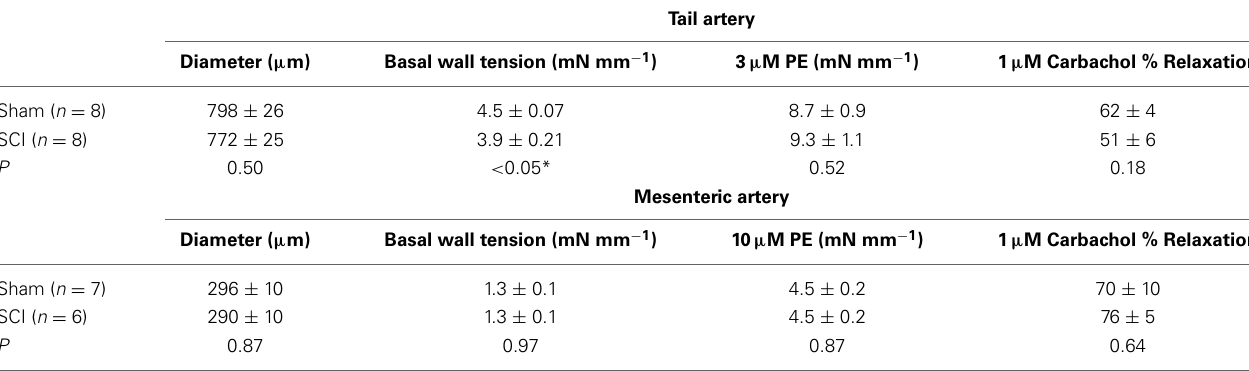
Table 1 | Basal lumen diameter and wall tension and the responses to phenylephrine (PE) and carbachol in tail and mesenteric arteries from sham-operated and SCI